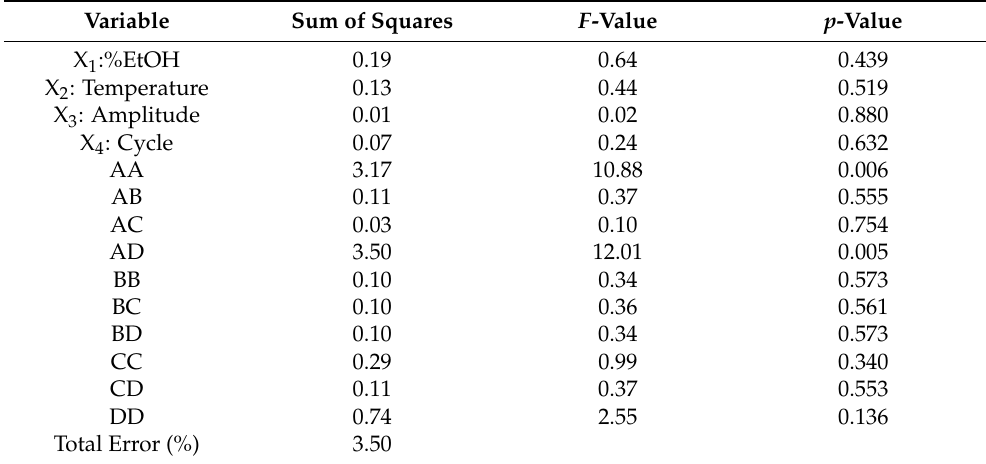
Table 2. Results from the BBD–RSM analysis on the betalains extracted from Opuntia dillenii